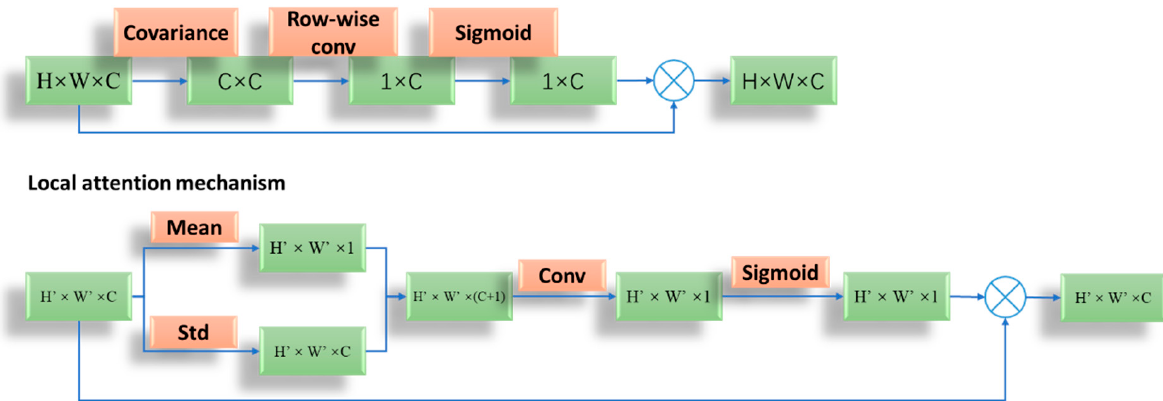
Figure 9. The structure of Enhance-Net.